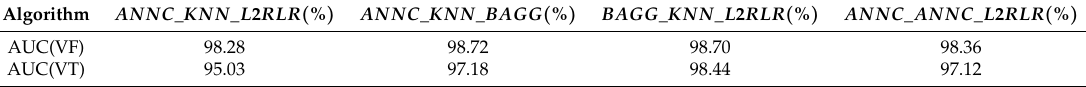
Table 16. AUC for VMM combination methods in detection of VF and VT .